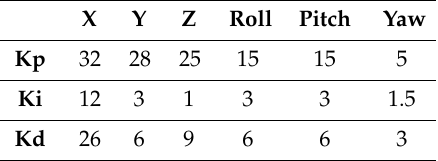
Table 4. PID gains used in this work.